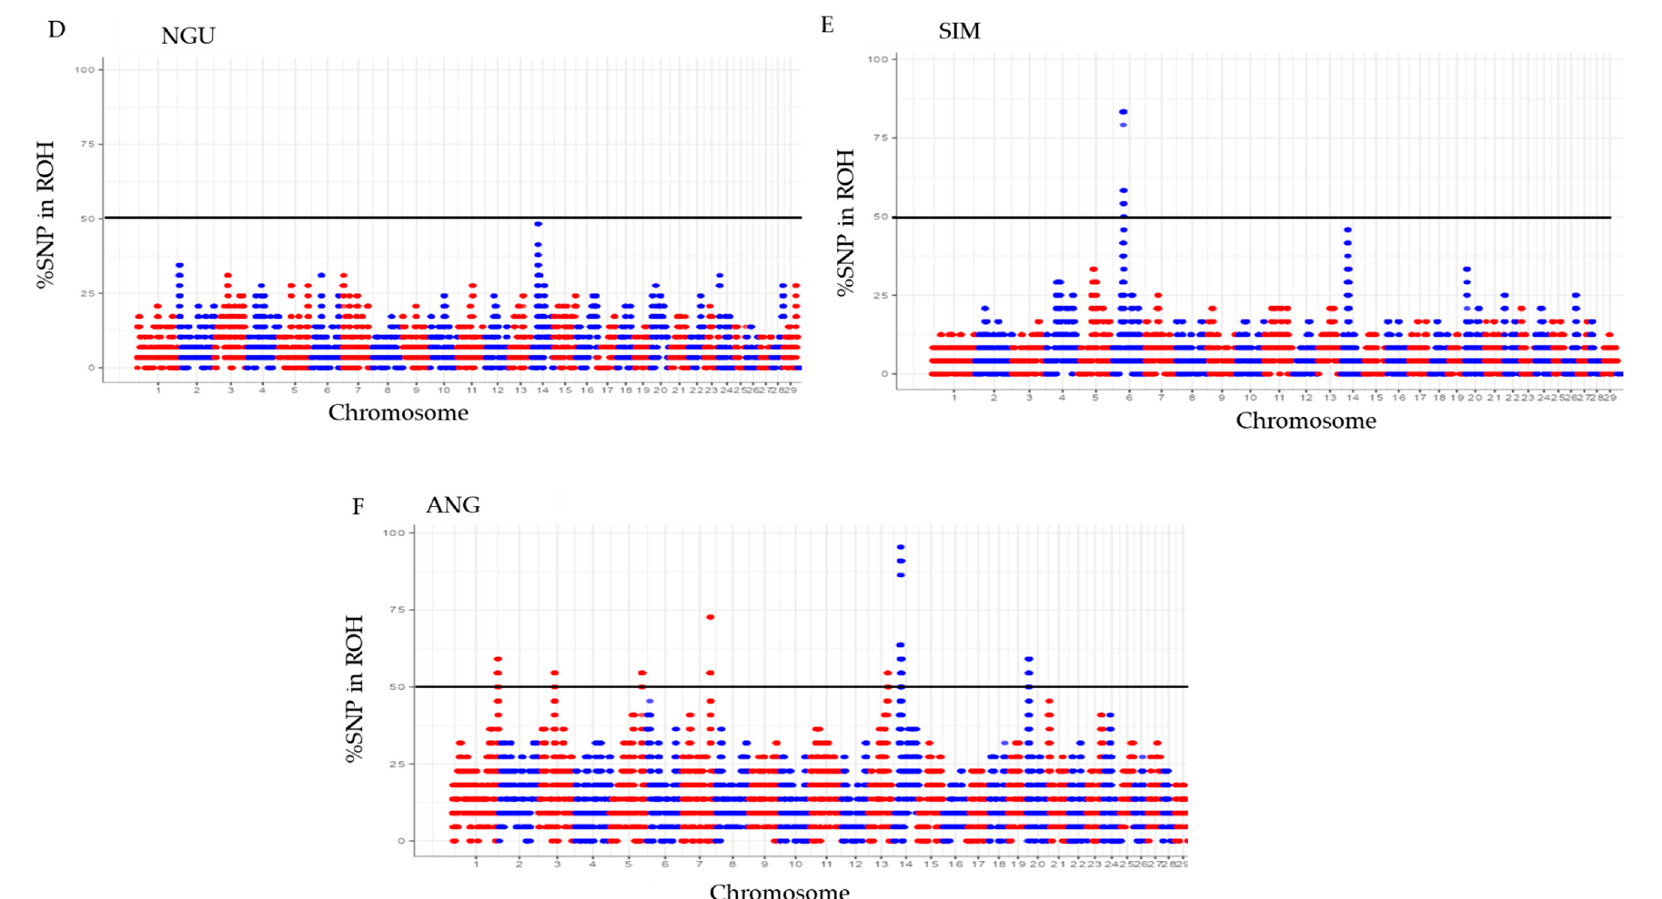
Figure 4. Manhattan plot for SNPs in ROH from the top to bottom ( A ) BEL, ( B ) CSI, and ( C ) BON, with BTA 14 having the most significant SNP in ROH for the three breeds. Manhattan plot for SNPs in ROH from the top to bottom ( D ) NGU, ( E ) ANG, and ( F ) SIM, with ANG having the most significant SNP in ROH on BTA 1,3, 5,7,13,14, and 20 compared to SIM and breeds.3.3. QTL and Identification of Candidate Genes within Runs of Homozygosity.